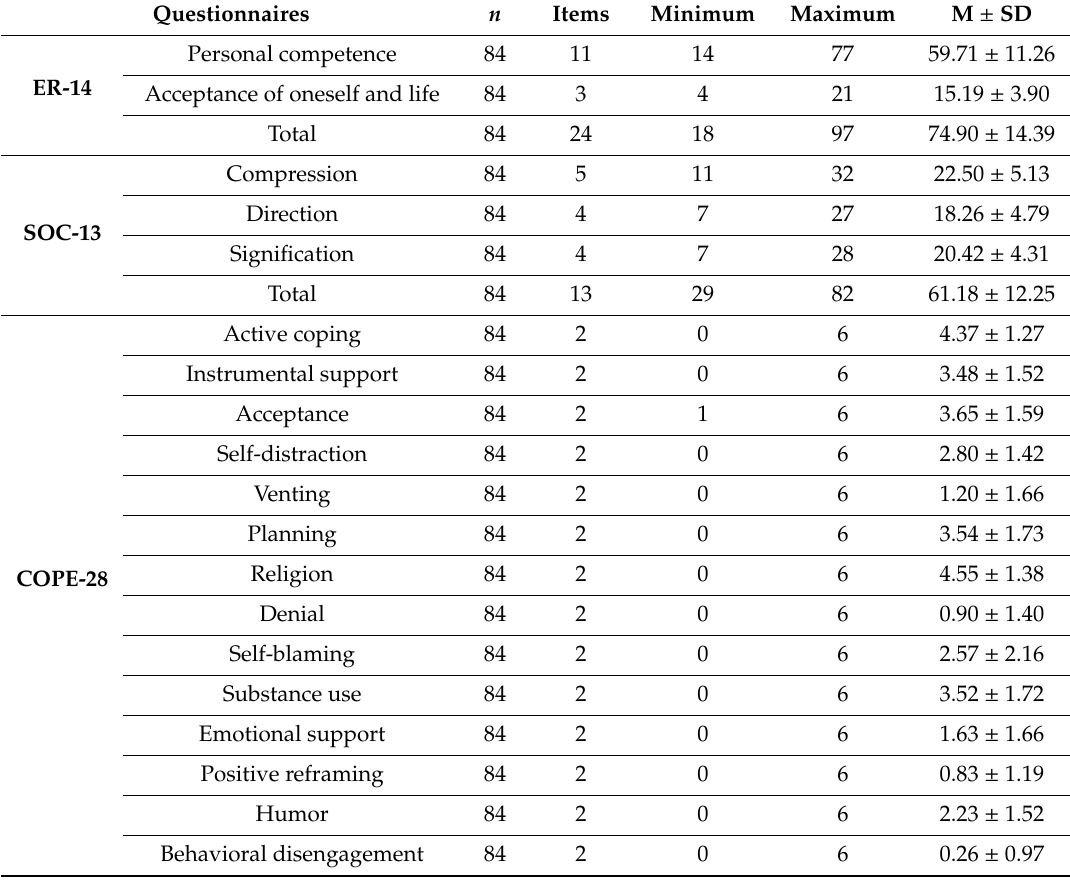
Table 4. Descriptive statistics of resilience, sense of coherence and